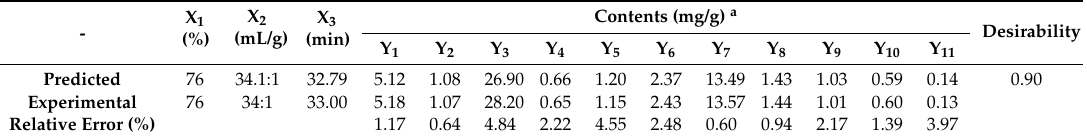
Table 4. Predicted values and the results of verification experiment. Table 4 Predicted values and the results of verification experiment.